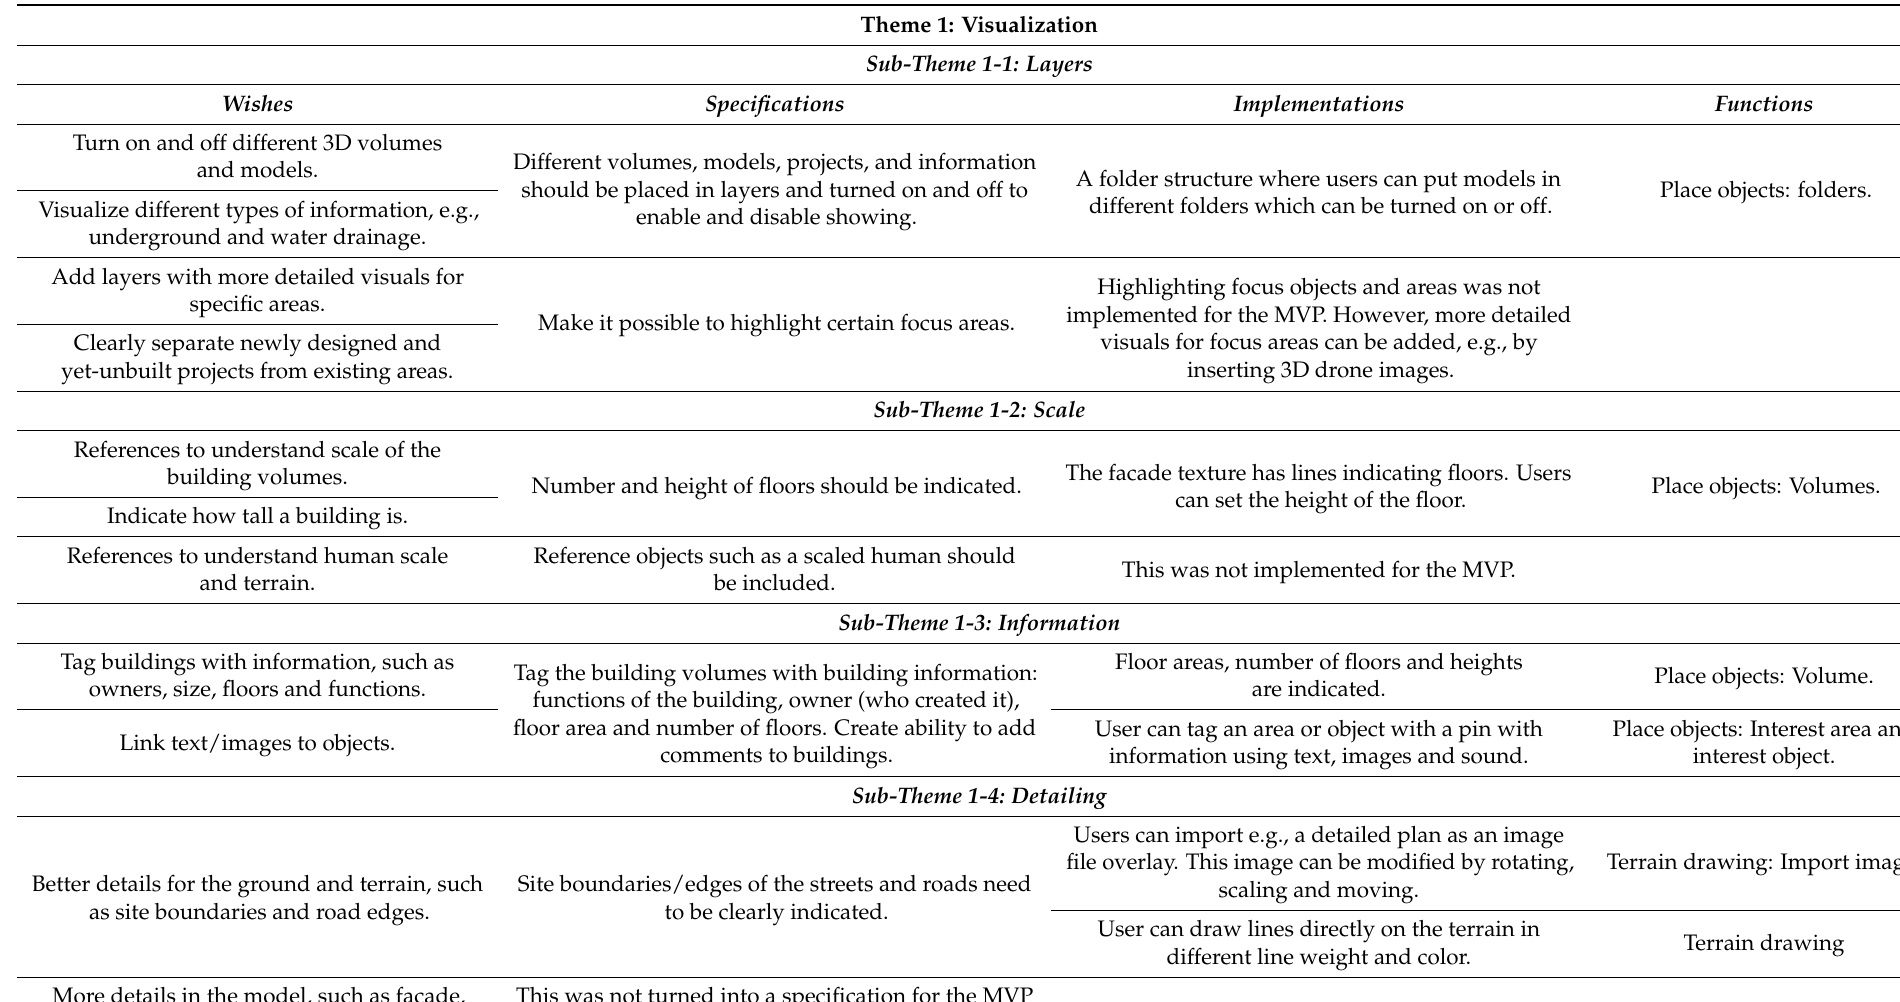
Table 1. Stakeholder wishlist, specifications, implementations and related functions for the